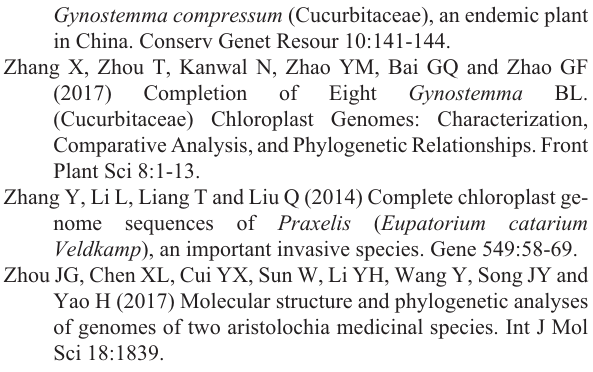
Table S2 - Types and numbers of SSR identified in the Table S3 - Chloroplast genome sequences used for phylo- genetic tree construction. Table S4 - List of 77 chloroplast protein coding genes